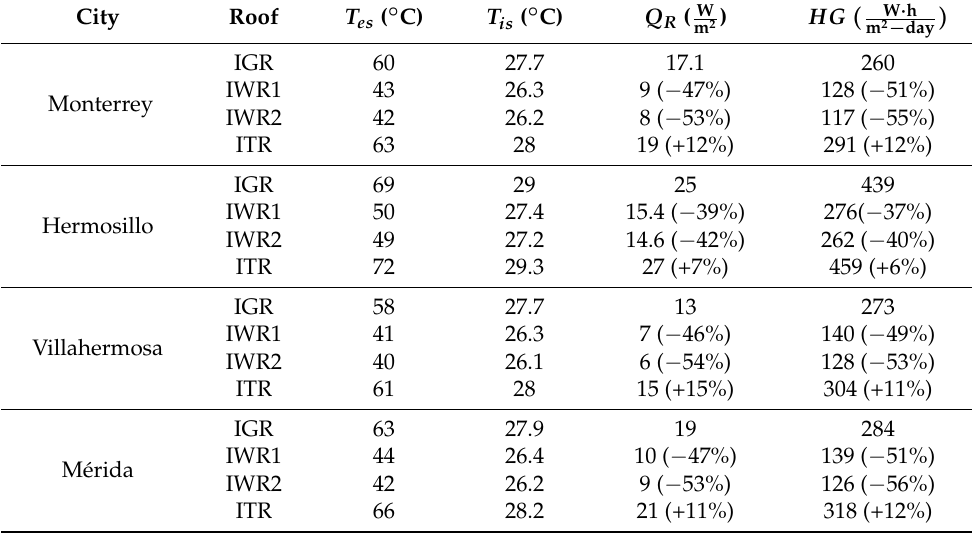
Table 4. Summary of the thermal evaluation of insulated roof in four cities of Mexico (Average peak values for the different variables). T es ( ◦